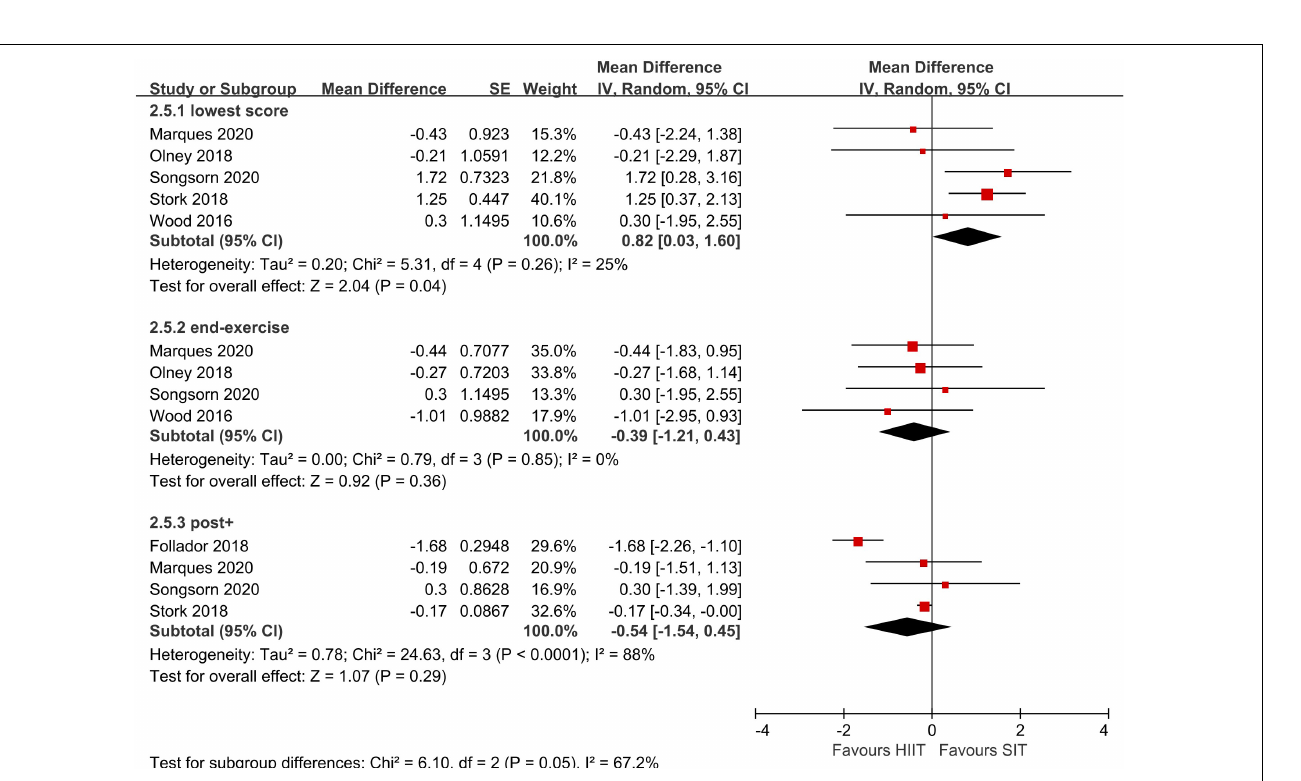
Frontiers in Psychology |